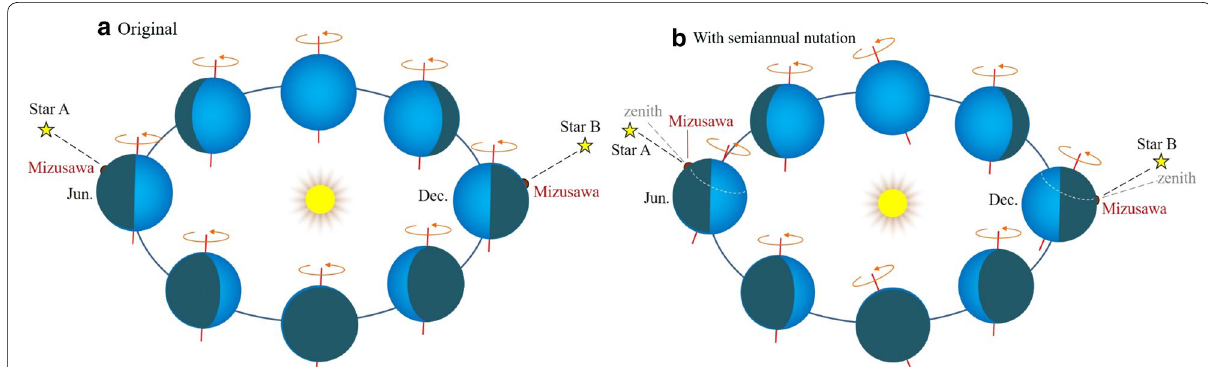
Fig. 5 Semiannual nutation and the Z-term. Here, we assume that, under the situation without nutation, Stars A and B are seen at the zenith from Mizusawa at midnight in June and December, respectively ( a ). With a significant amplitude of semiannual nutation ( b ), visible positions of Stars A and B from Mizusawa at midnight deviate in opposite directions from local zenith in June and December, causing annually varying bias (Z-term) to the astronomical latitude variation. Such biases appear as a common value for all observatories along the latitude 39° 08 ′ N (white dotted circle). For the sake of simplicity, I excluded astrometric effects of the nutation terms other than the semiannual term, precession, and polar motion in this